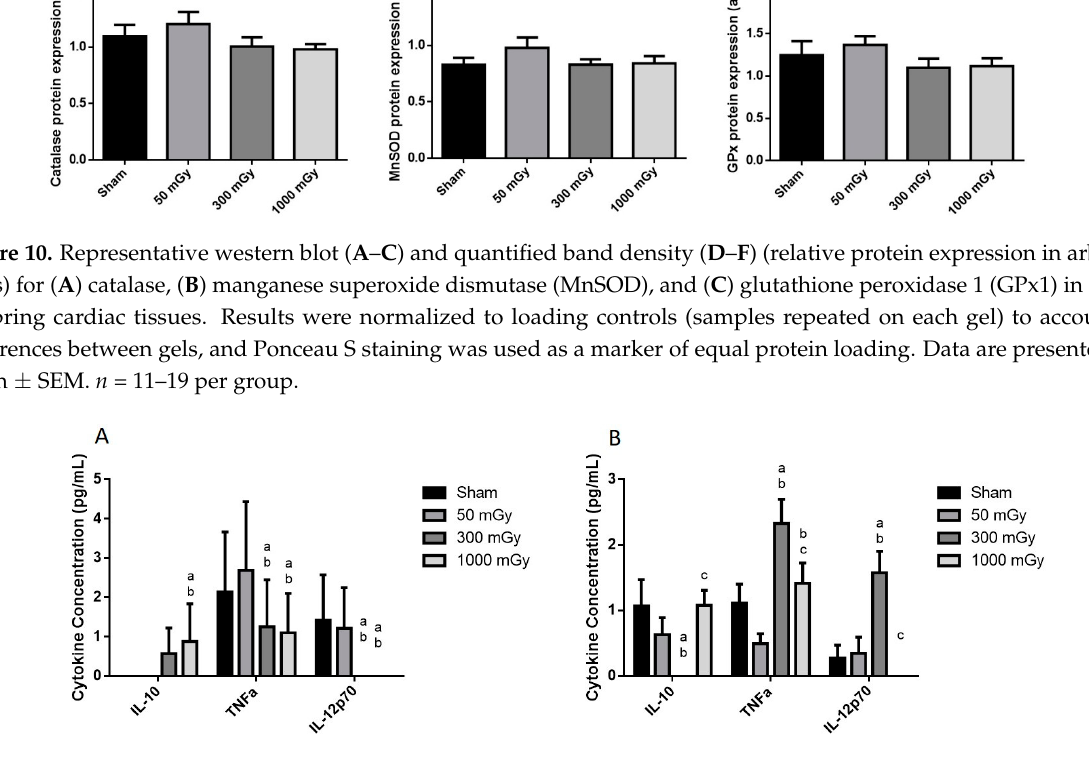
Figure 11. Plasma cytokine concentration in offspring after being exposed to IR in utero. ( A ) male and ( B ) female plasma concentrations of cytokines. Data are presented as a mean ± SEM. a—is significantly different from Sham, b—is significantly different from 50 mGy, and c—is significantly different from 300 mGy, p ≤ 0.05. n = 11–19 per group.